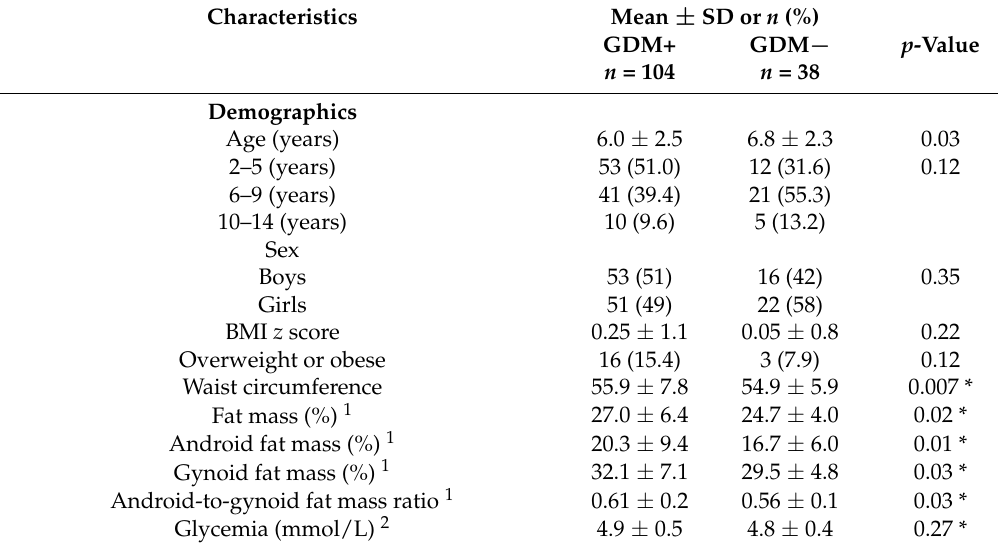
Table 1. Participant